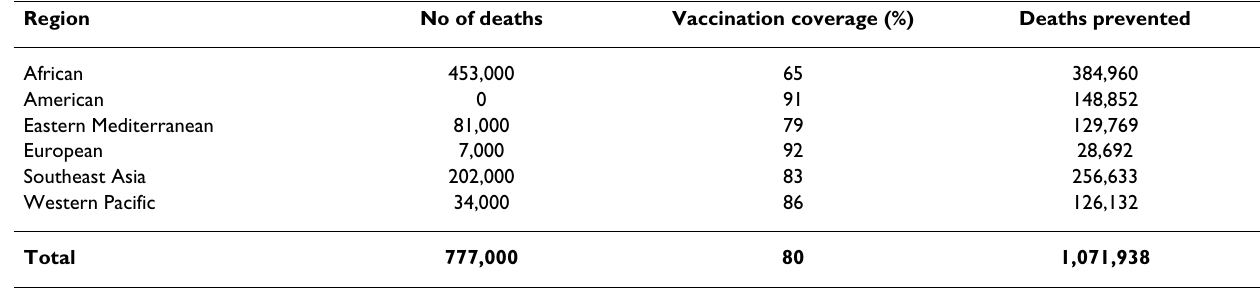
Total Source: Adapted from Henao-Restrepo (2003)